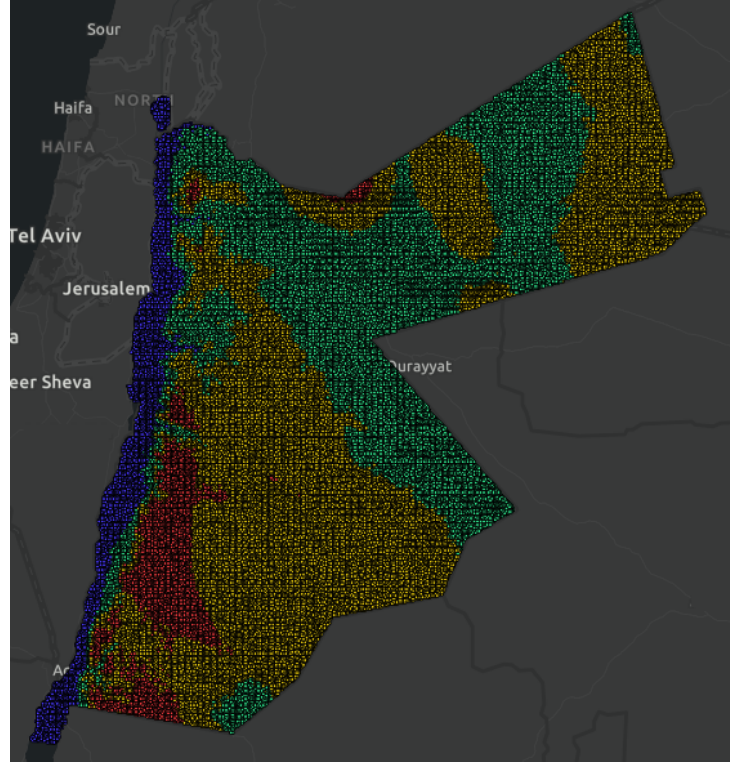
Figure 5. Elevation clustering in Jordan with k =